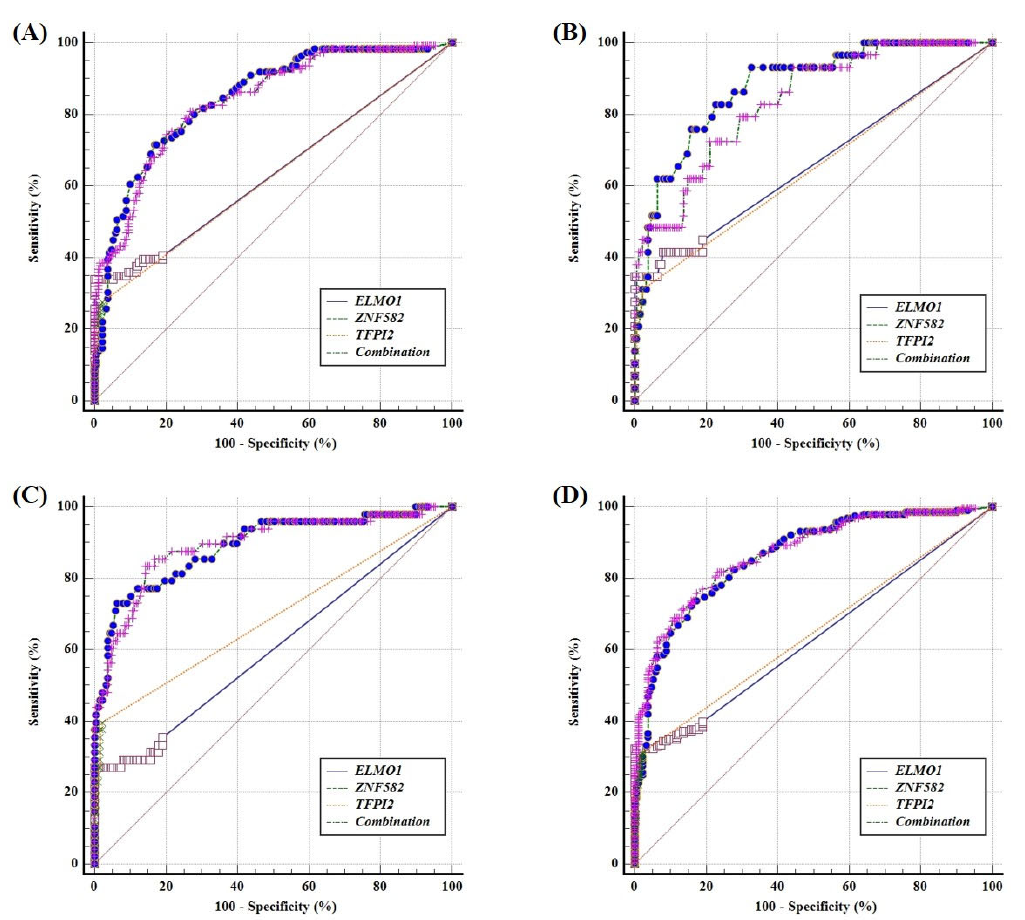
Figure 4. The ROC curves of methylation panel in different samples. ( A ) GC, ( B ) EJC, ( C ) EC, ( D ) UGC. Table 2. Sensitivities of methylation panel in different groups.